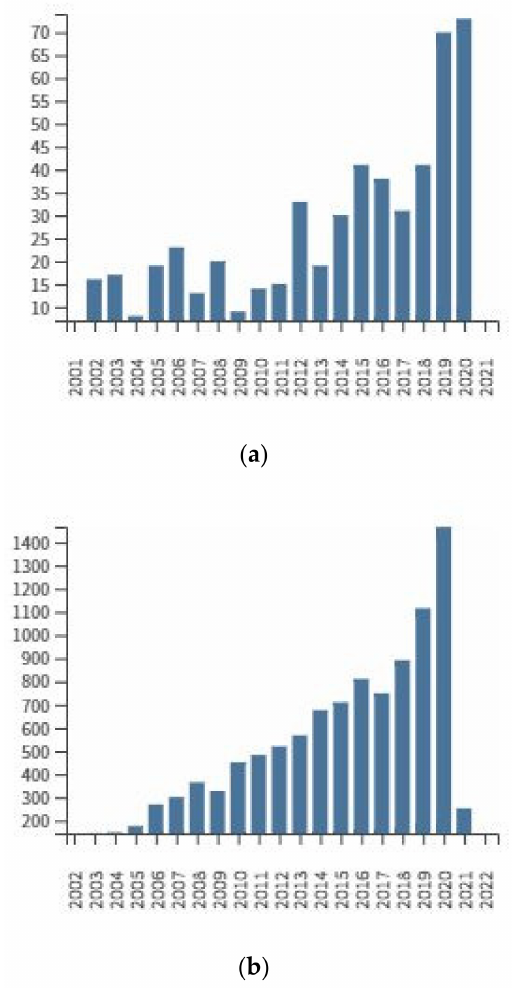
Figure 3. Total publications by year ( a ) and sum of times cited by year ( b ) for amygdalin as a topic (Web of Science ® , accessed on 3rd March